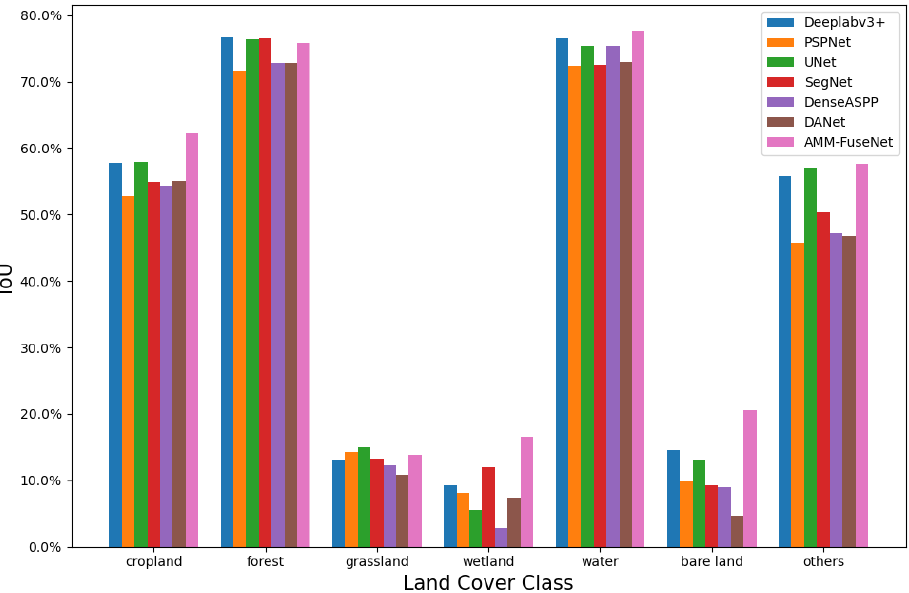
Figure 6. IoU of each land cover class on the Hunan dataset (Sentinel-2 and